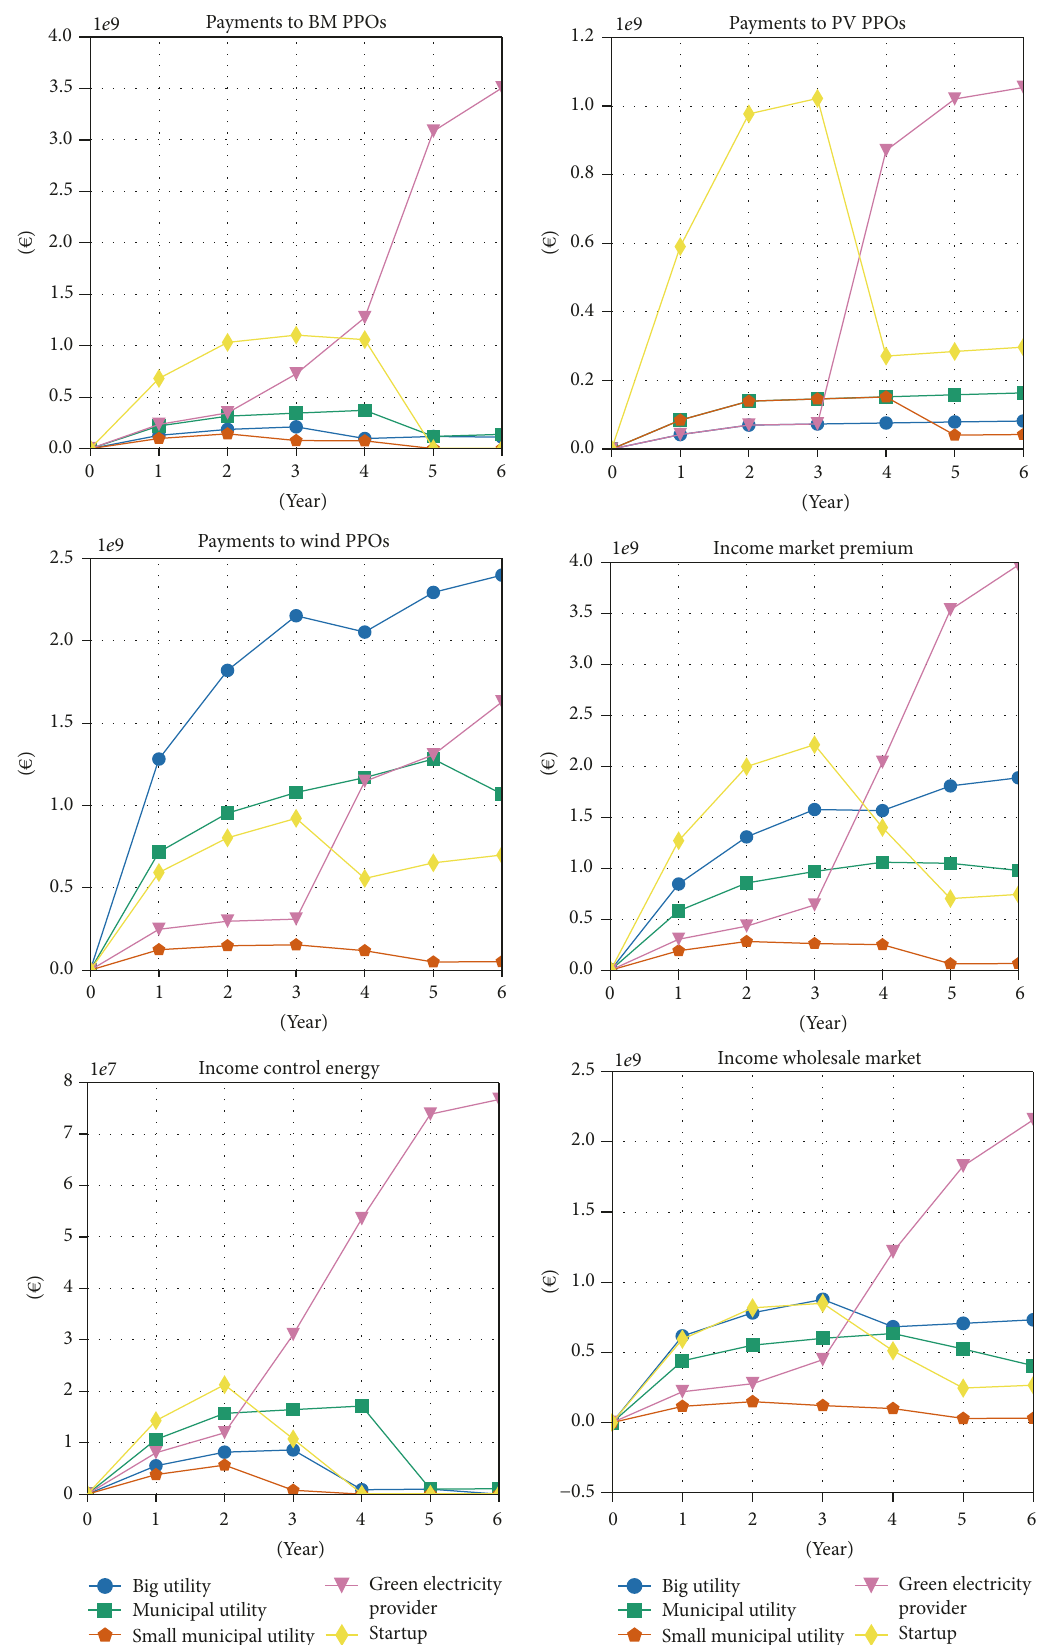
Figure 11: Scenario 2 results. Income and expenses of the